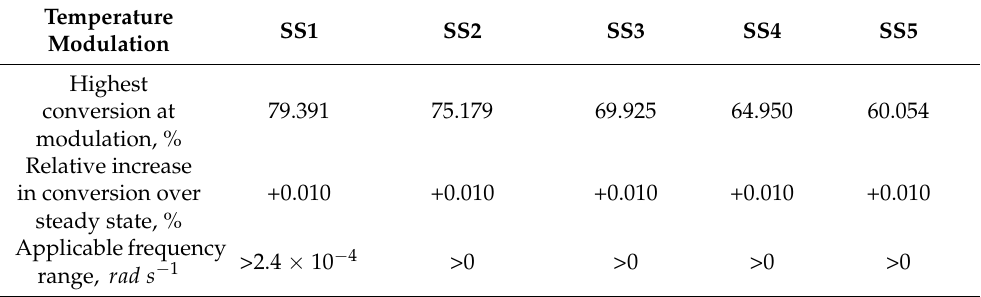
Table 4. The improvement owing to periodic modulation of the reactor temperature for the chosen five steady-state points with a relative amplitude of 5.88% (absolute value is 20 K).